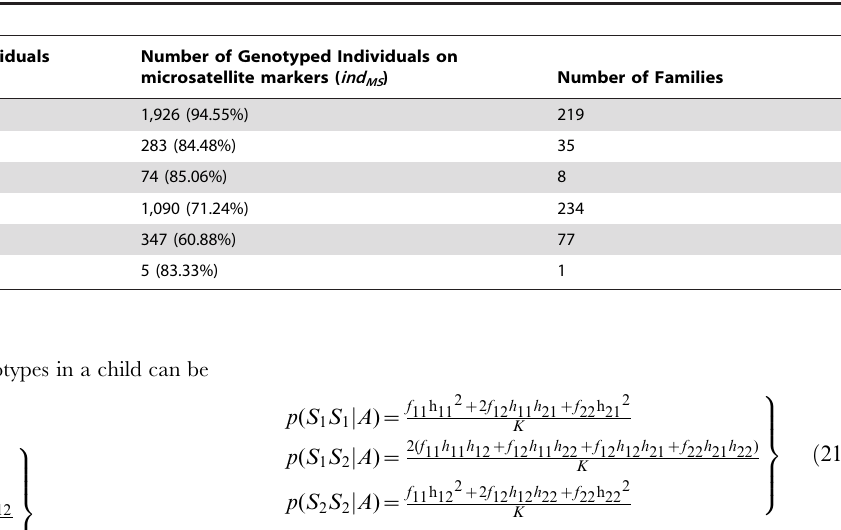
Table 4. Number of total and genotyped individuals, and corresponding number of families that these individuals are selected